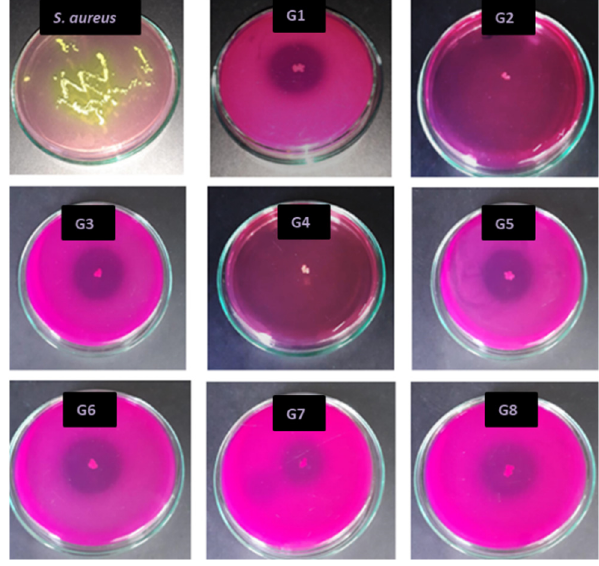
Figure 2. Antimicrobial activity against S. Aureus.